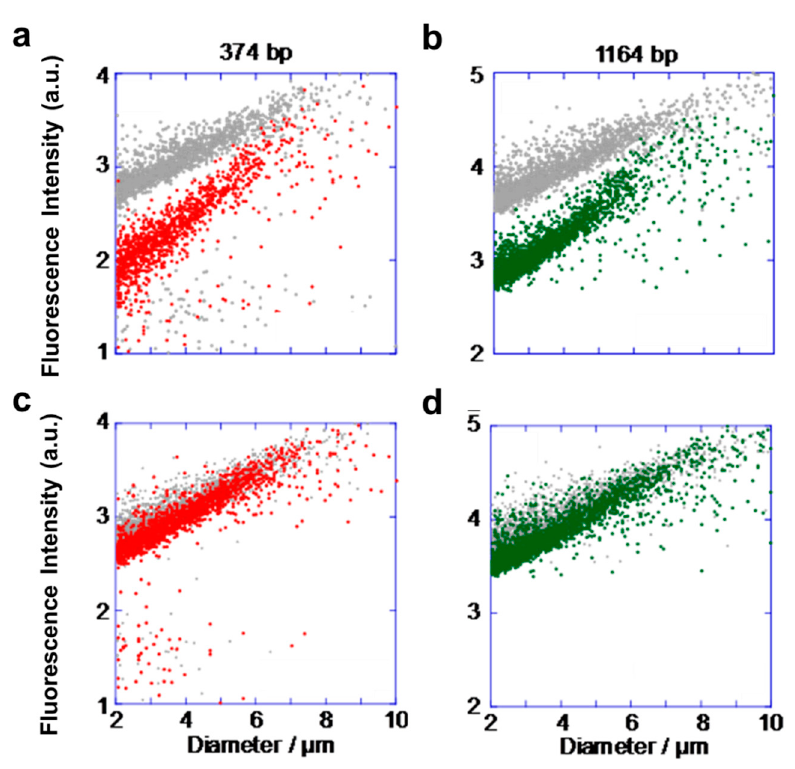
Figure 5. Flow cytometry diagrams showing the correlation between the diameters which is given by correlation with size of polystyrene beads (Figure S9) and fluorescence intensities of GV(S) and GV(M) in competitive proliferation. The two diagrams in the left column ( a) and ( c ) correspond to population changes of GV(S). The two diagrams in the right column ( b ) and ( d ) correspond to population changes of GV(M). The ratio of V* and total membrane lipids is 3:1 in the top row and 1:3 in the bottom row.